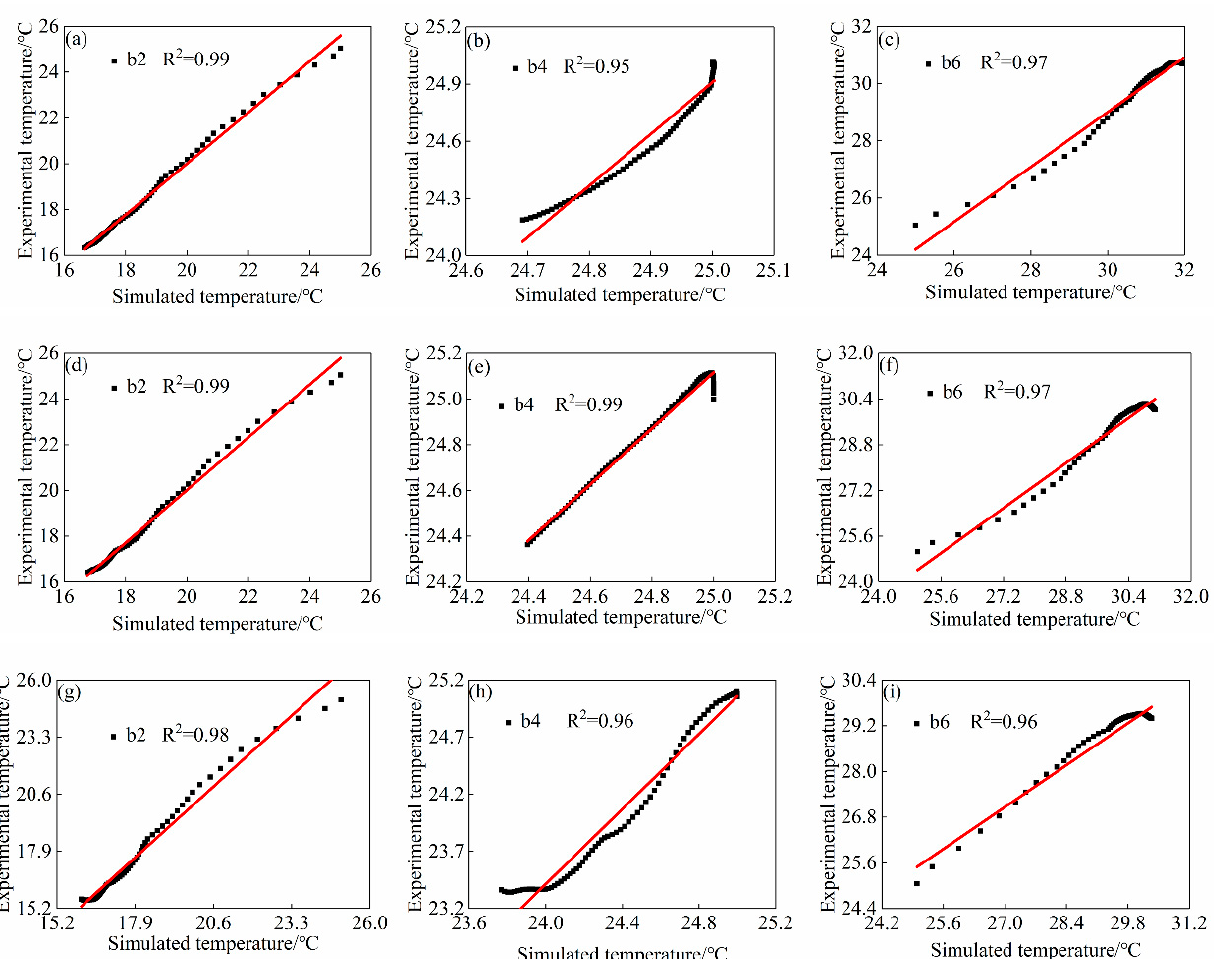
Figure 6. Comparison of simulated and experimental temperature at different measuring points of bulk grain pile: ( a – c ) 50 kPa ( d – f ) 100 kPa ( g – i ) 200 kPa.